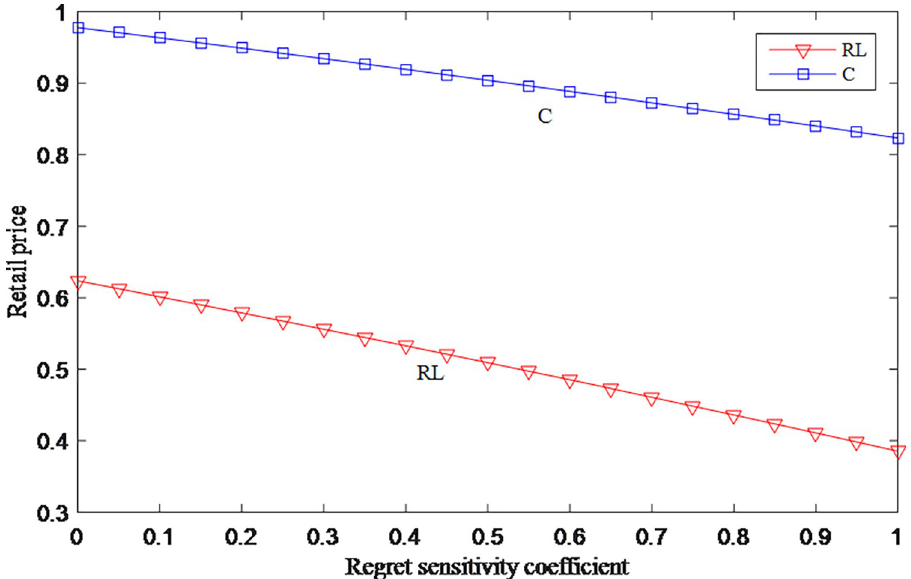
Fig 1. The impact of anticipated regret on retail